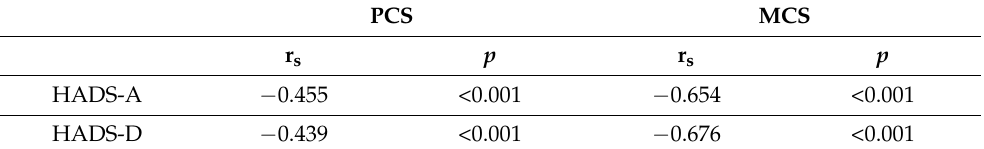
Table 5. Relationship between anxiety, depression, and quality of life in patients with adenomyo- sis.